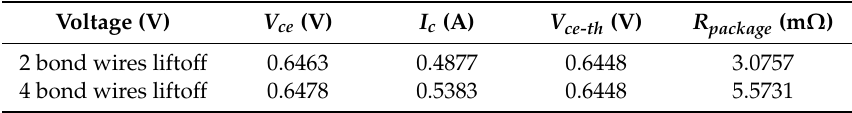
Table 3. R package at di ff erent aging periods (T j = 25 ◦